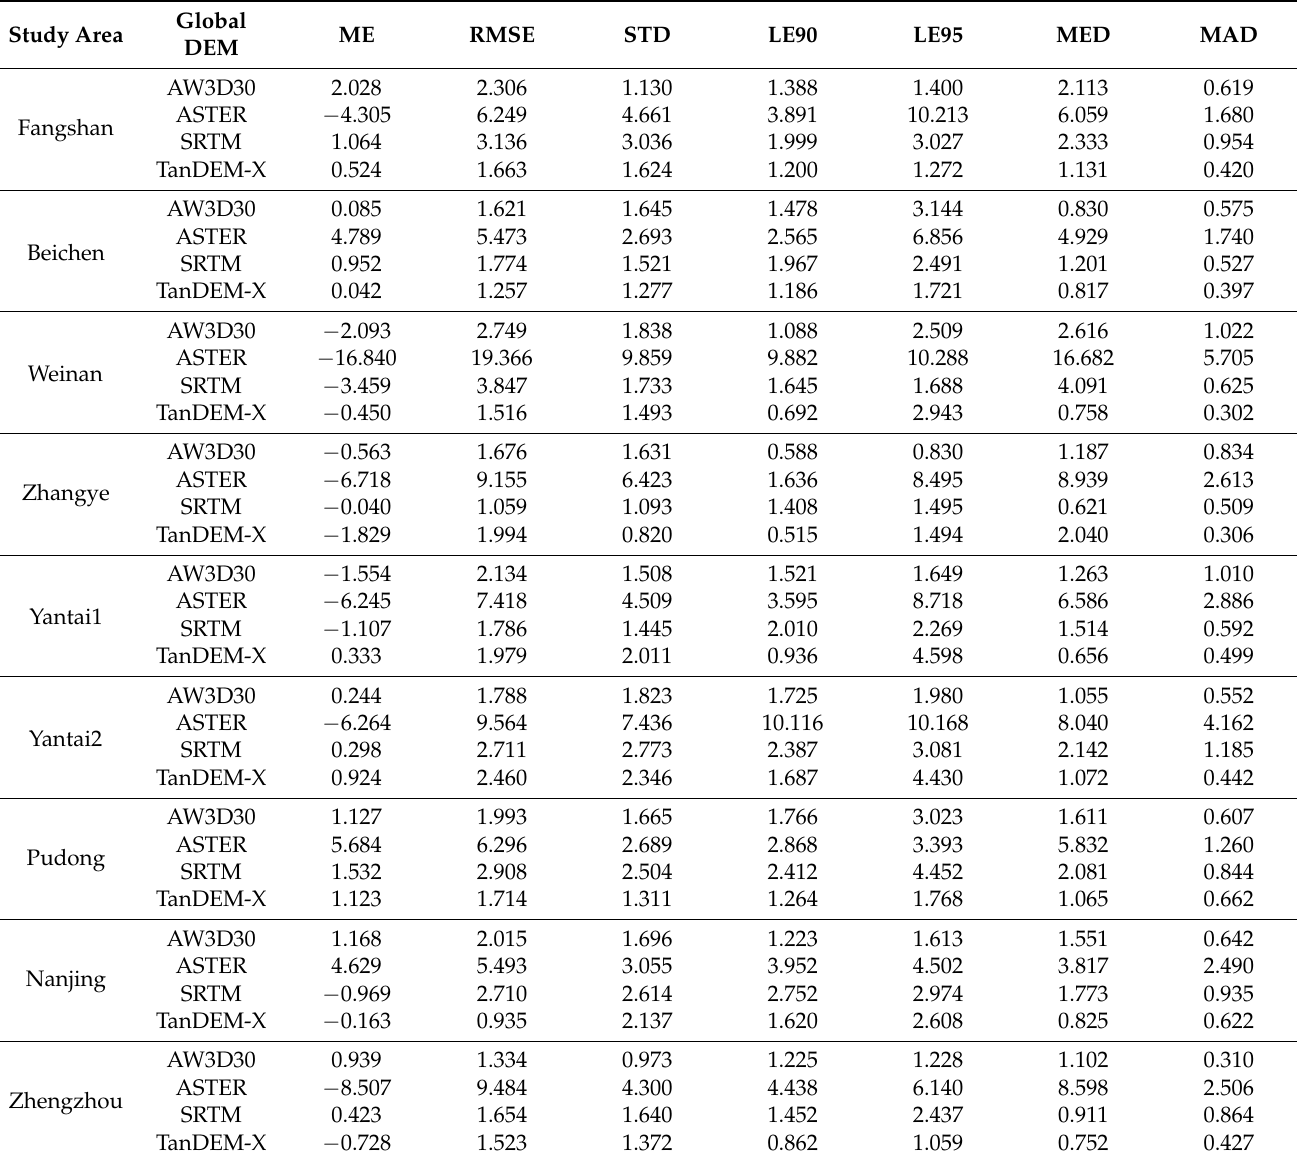
Table 5. Error measurements of the four global DEMs across the 16 study areas. Error terms include: mean error, ME; root mean square error, RMSE; standard deviation, STD; confidence levels at 90% and 95%, LE90 and LE95; median error, MED; median absolute deviation, MAD. The above units are in